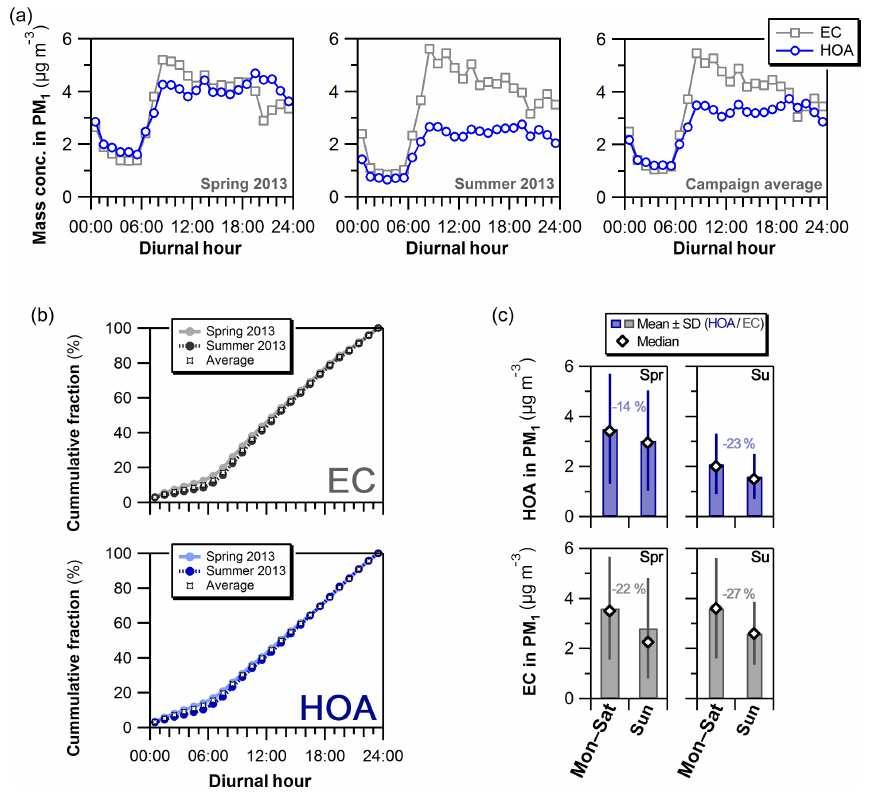
Figure 1. (a) Diurnal variation of HOA and EC mass concentrations in spring 2013 (7 March 2013 to 15 May 2013), summer 2013 (16 May 2013 to 19 July 2013) and averaged over the entire sampling campaign (7 March 2013 to 19 July 2013). (b) Diurnal variation of the cumulative fraction of total daily HOA and EC mass concentrations in spring 2013, summer 2013 and averaged over the entire sam- pling campaign. (c) Mean HOA and EC concentrations (bar with standard deviations; the marker depicts the median) from Monday through Saturday and on Sunday in spring 2013 (Spr) and summer 2013 (Su); days with > 25% ( > 6h) of missing data were